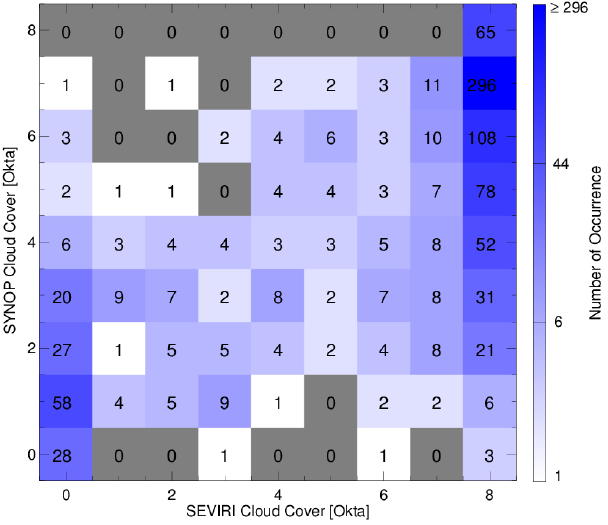
Figure 6. Density plot of the occurrences of the CFC by SYNOP as a function of instantaneous CFC in oktas by SEVIRI. Each color of one box represents the amount of matches at the respective CFCs by SYNOP and SEVIRI. The total of all valid matches is 996 and rep- resents the results from 1 July to 30 September 2009 for Hannover, Germany.